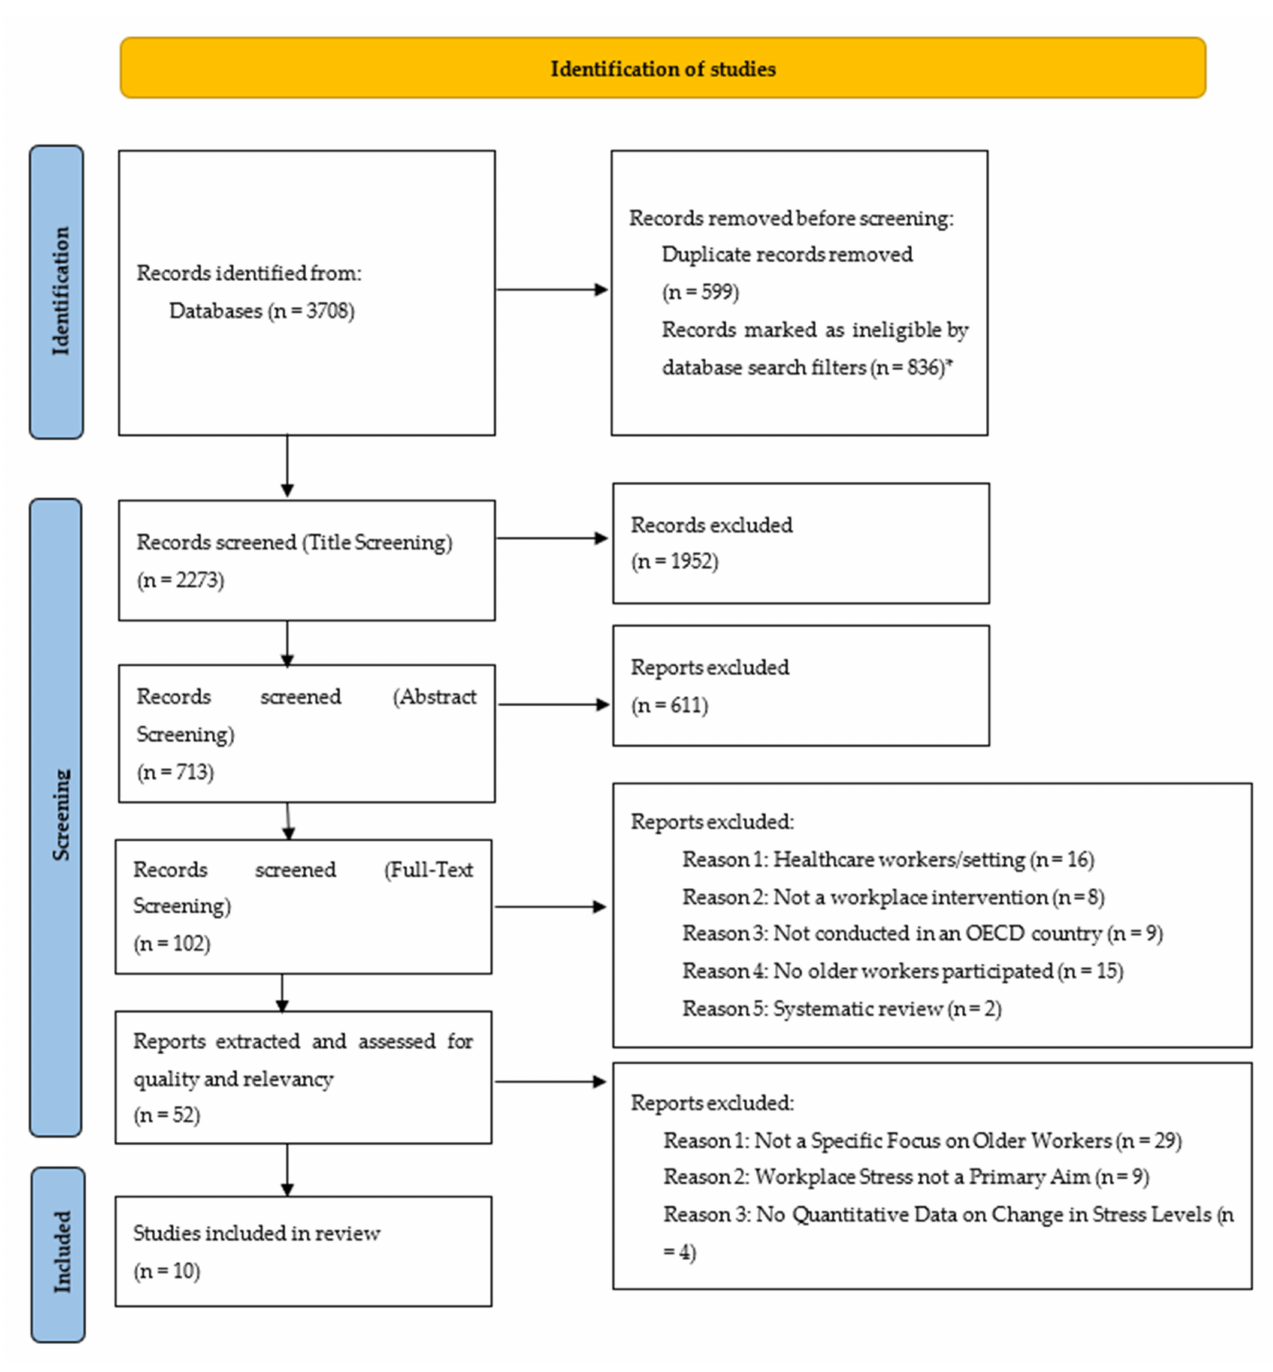
Figure 1. PRISMA Flow Chart (Adapted from Page et al. [12]) * Papers were automatically excluded using filters in the search databases where they were outside of our date range and language of